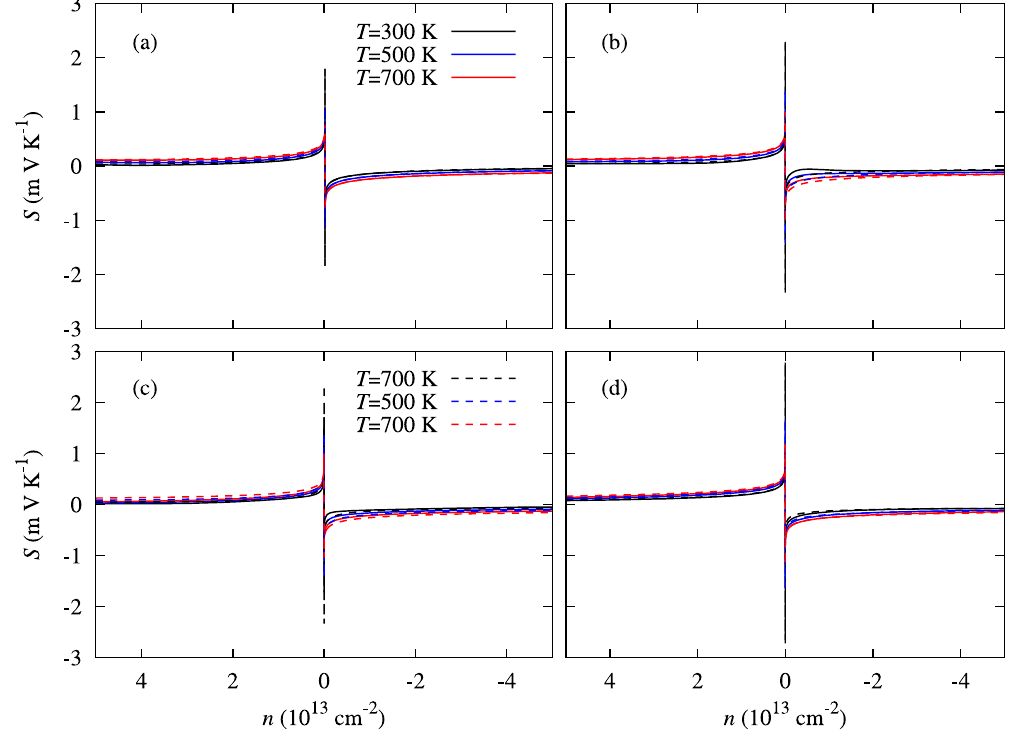
Figure 4. Calculated Seebeck coefficients ( S ) as a function of the carrier concentration ( n ) along the armchair (solid lines) and zigzag (dashed lines) directions at 300 K, 500 K, and 700 K for the group IV–VI monolayers ( a ) SnSe, ( b ) SnS, ( c ) GeSe, and ( d ) GeS.